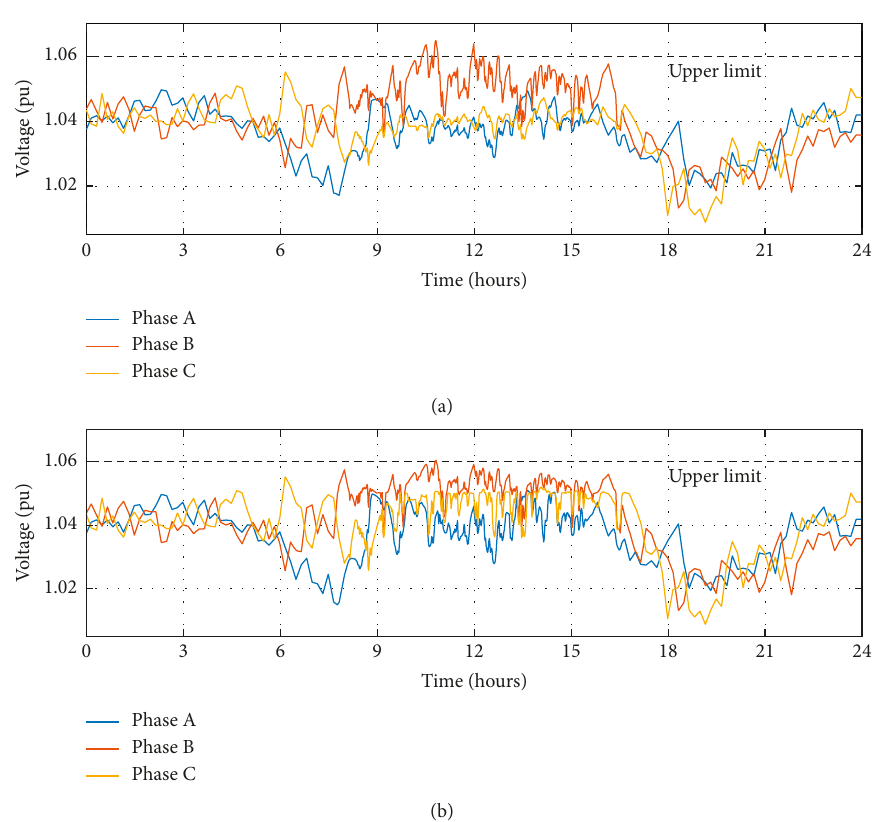
Figure 11: Voltage regulation performance of power factor droop curves with different parameters: (a) V 0.94pu, 0.97 pu, 1.03pu, and 1.06 pu, respectively; (b) V